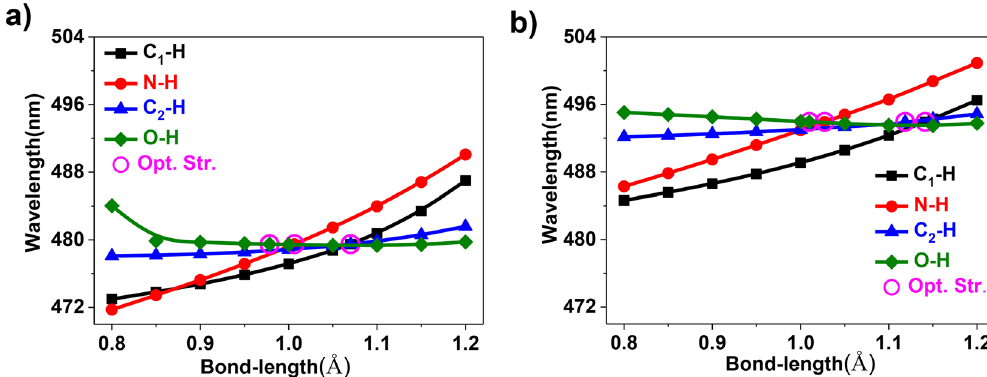
Figure 4. Relationship between the emission wavelengths and relevant bond lengths. The calculated emission maximum as a function of selected bond lengths for the modified chromophore with hydrogen in the ( a ) absence and ( b ) presence of water molecules in aqueous